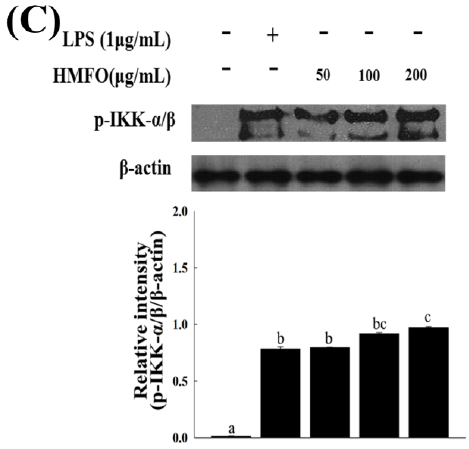
Figure 6. HMFO ‐ induced nuclear factor kappa B (NF ‐κ B) activation by the phosphorylation of inhibitor of kappa B (I κ B) ‐α and I κ B kinase (IKK) ‐α / β in RAW 264.7 macrophages. Cells were stimulated with HMFO (50, 100, or 200 μ g/mL) or LPS (1 μ g/mL). ( A ) Nuclear extracts (N) were isolated from cells stimulated with HMFO or LPS. Level of p65 in the nuclear fractions was determined by immunoblotting analysis; ( B , C ) Phosphorylated I κ B ‐α and IKK α / β isolated from cell lysates were determined by immunoblotting analysis. β‐ actin was used as an internal control. Values with the different letters are significantly different ( p < 0.05).